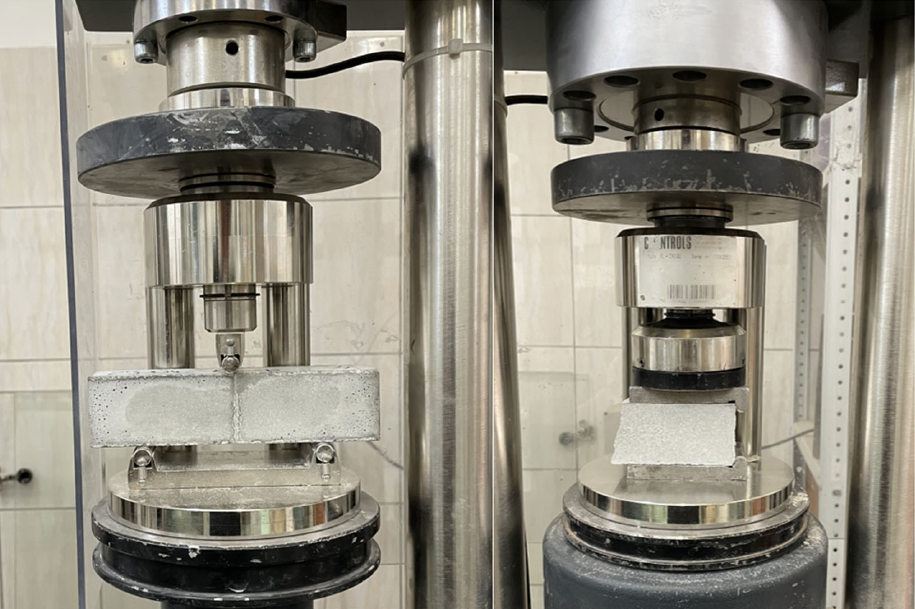
Figure 8. Testing of samples in accordance with GOST 310.4-81.